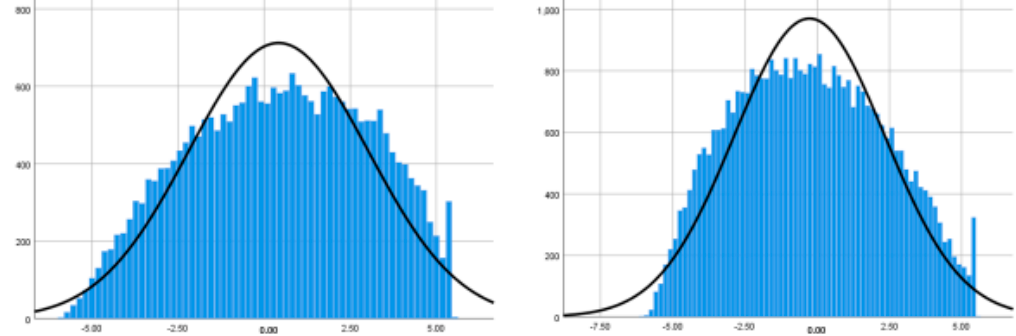
Figure 2. The frequency distribution of dietary inflammatory index (DII) score for two subgroups. The horizontal axis indicates DII score, and the vertical axis indicates the number of participants.